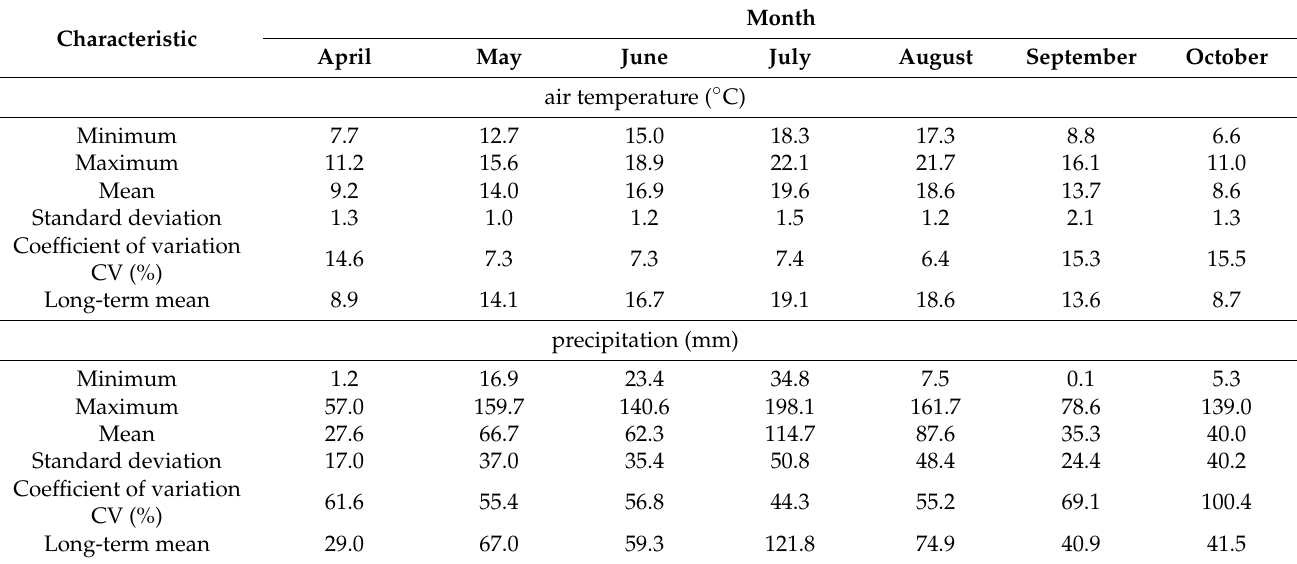
Table 3. Characteristics of meteorological conditions during the 2006–2016 sugar beet growing seasons and in the long